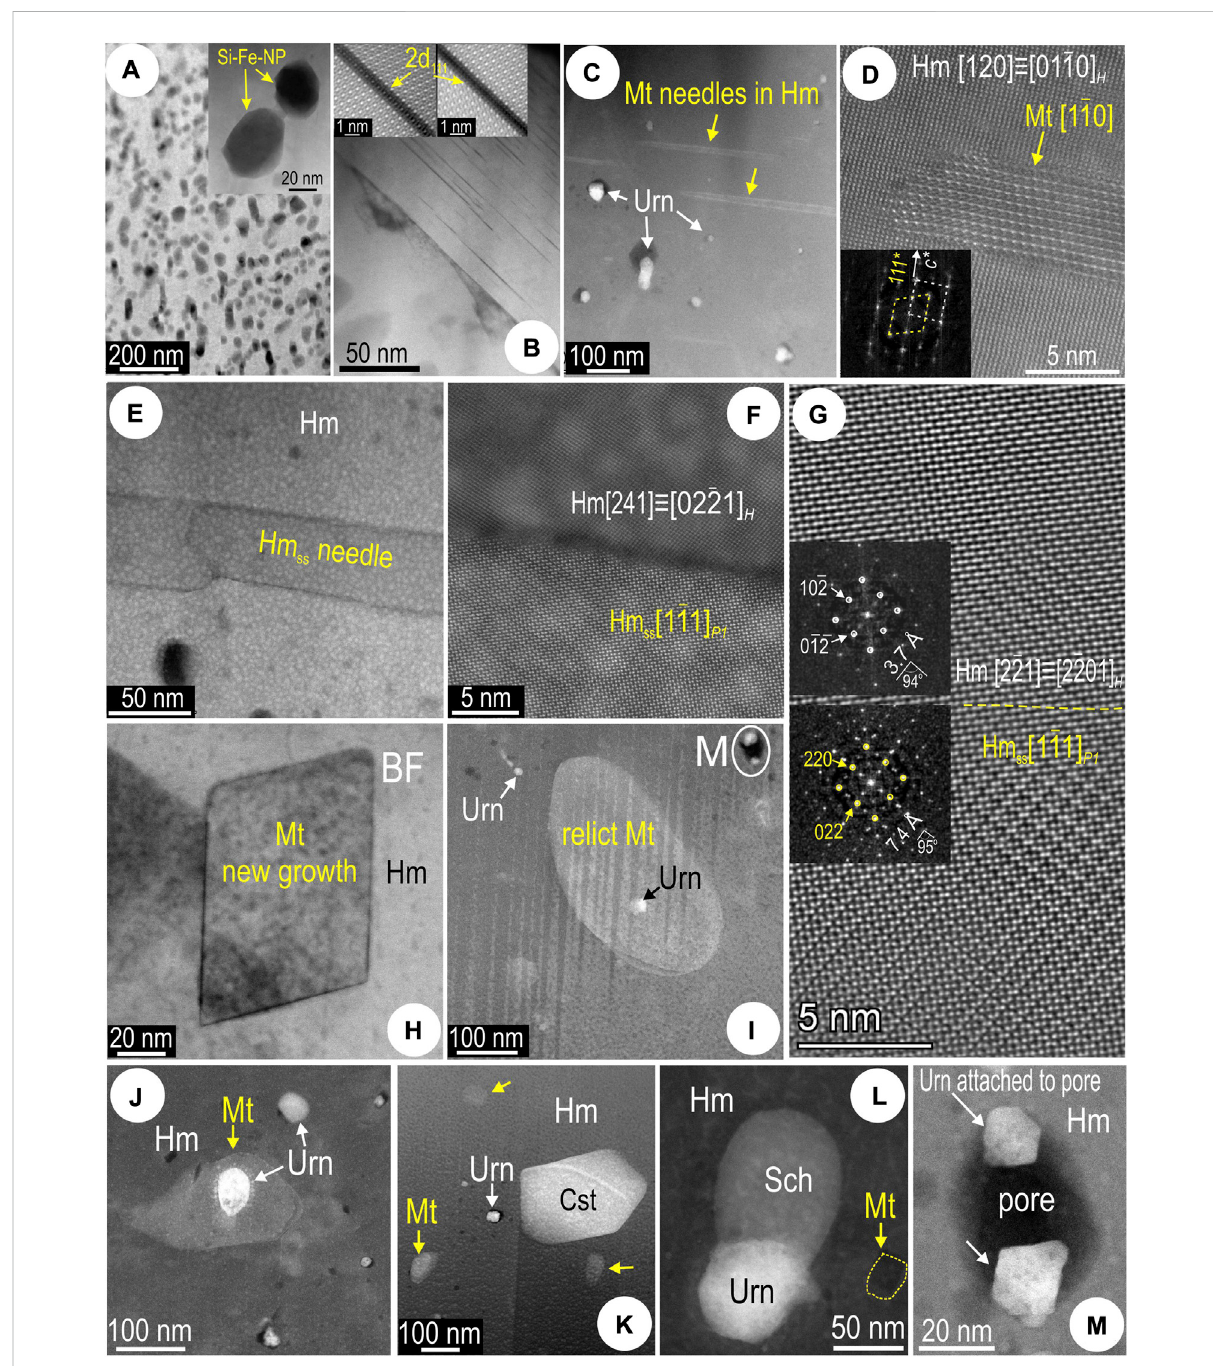
FIGURE 4 HAADF STEM images showing aspects of silician magnetite and co-existing hematite (sample CLC21). (A) Mottled texture in silician magnetite comprisingSi-FeNPs(detailintheinset). (B) Grainboundaryinsilicianmagnetiteshowingdifferenttextures.GraintotherightisfreeofSi-FeNPsbut displays linear defects of 2d 111 width of magnetite (inset). (C) Magnetite (Mt) needles and uraninite (Urn) NPs in hematite (Hm). (D) Image and fast Fourier transform (FFT; inset) showing epitactic relationships between the magnetite needle and host hematite (zone axes given in square brackets). (E – G) Hematite superstructure (Hm ss ) identi fi ed as coherently intergrown needles in host hematite (Hm) in areas of martitization (foil Mt#3). High-resolution images [ (F,G) and FFT patterns as insets in (G) ] showing the congruent boundary between the two species. The phase along the needle is identi fi ed as the O-de fi cient, two-fold hematite superstructure ( a = b = c = 10.85 Å; α = β = γ = 55.28 ° ) de fi ned in Verdugo-Ihl et al. (2020) basedon amodelinvolvingorderedoxygen vacancies. (H) New growth ofnanocrystalline magnetiteinhematite. (I) Uraninite NPwithin relict magnetite (rounded grain) enclosed by hematite. (J) Uraninite within relict magnetite enclosed in hematite. (K) Relict magnetite and uraninite adjacent to cassiterite (Cst). (L) Composite NP comprising uraninite and scheelite (Sch) in hematite. (M) High-magni fi cation image of pore-attached uraninite NPs located on (I)